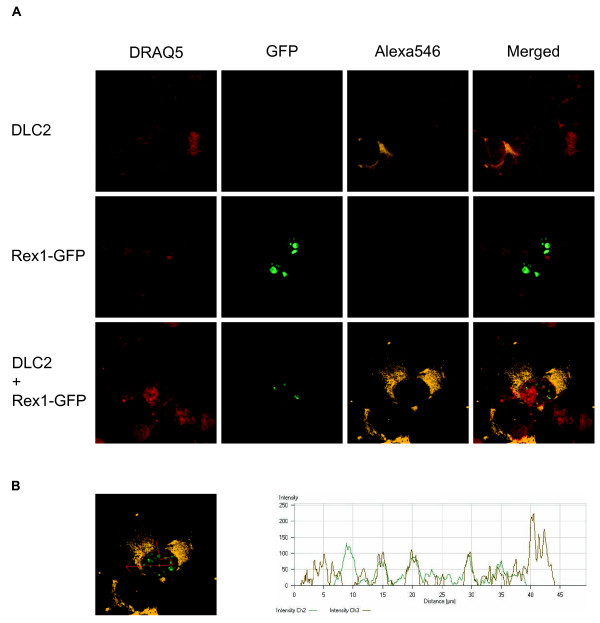
HTLV-1 Rex and DLC2 co-localize in nucleolar foci. (A) HeLa cells were transfected with expression vectors for Rex1-GFP and Flag-DLC2 as indicated. Twenty-four hours post-transfection, cells were labeled with anti-flag M2 mouse antibody followed by alexa546-conjugated anti-mouse secondary antibody. Cells were stained with the far-red DNA marker DRAQ5 and analyzed by confocal microscopy. Merge corresponds to the simultaneous acquisition of all three fluorochromes. (B) Fluorescent intensities were plotted along the red line segments. The green and orange lines in the profile correspond to the relative intensities of GFP and Alexa 546.